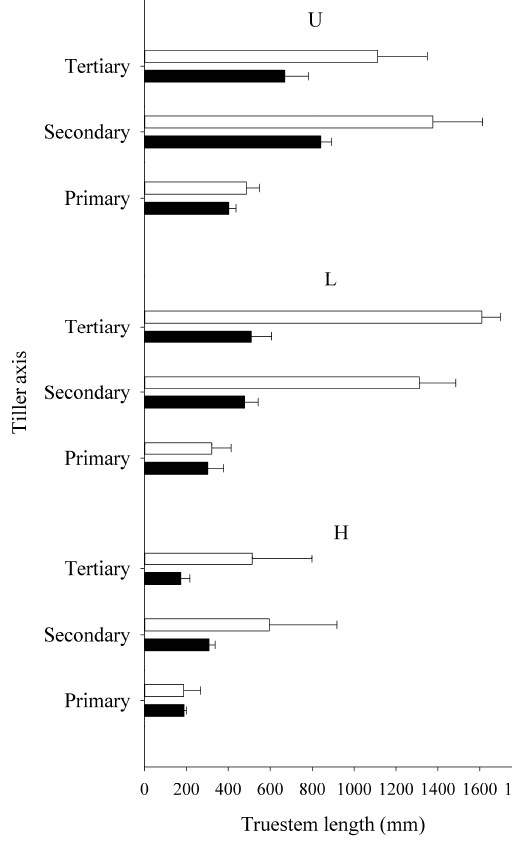
Figure 3. Mean ± SE for total true stem length of primary, secondary and tertiary tiller axes of non-rhizomatous ( ■ ) and rhizomatous ( □ ) tall fescue populations when plants were undefoliated (U), or subject to lax (L) defoliation to 100 mm stubble, or hard (H) defoliation to 50 mm stubble every three weeks for 18